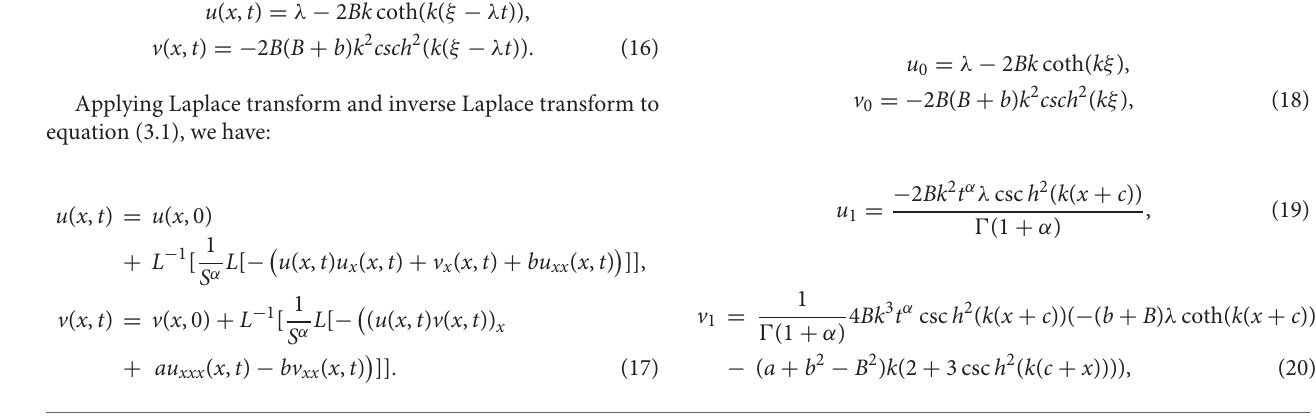
TABLE 5 | Second-order DJ solution for v ( x , t ) in comparison with ADM, VIM, and OHAM solutions at α